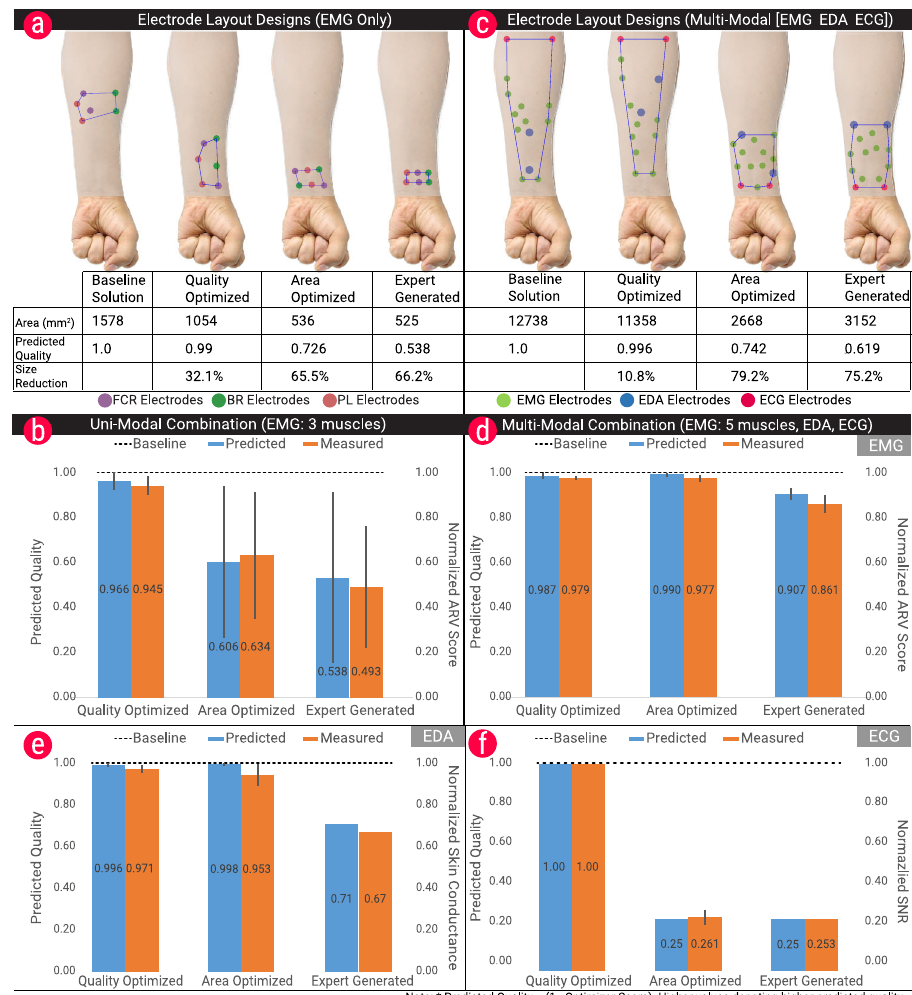
Fig. 3 Comparison of the optimizer results with conventional designs and the experimentally collected physiological data. a Visual representation of the generated designs for the uni-modal combination, involving EMG with three muscles, alongside their area and quality score predicated by the optimizer (values are normalized w.r.t. the baseline solution). b Comparison of model prediction with empirically measured quality scores of EMG sensing. The model is able to accurately predict the sensing quality (values are normalized w.r.t the baseline solution). c Visual representation of the generated designs for the multi-modal combination, involving EMG with fi ve muscles, EDA and ECG. d – f Modality-wise comparison of model prediction with empirically measured quality scores for EMG, EDA, and ECG sensing, showing the model accurately predicts the sensing quality. Note: The optimizer score ranges between 0 and 1, with 0 being the best. For better clarity, the graphs plot the complement value (1 – Optimizer Score), which gives a direct measure of the quality predicted. Error bars indicate standard